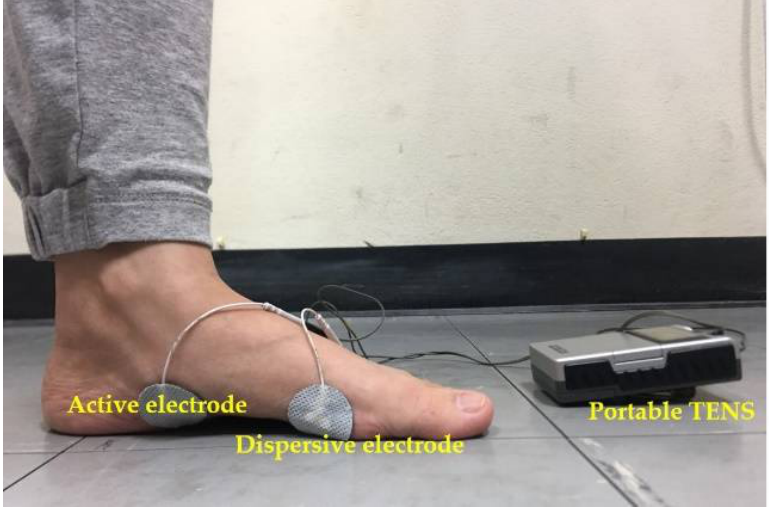
Figure 2. Adhesive electrode placements and portable TENS during the TENS procedure.